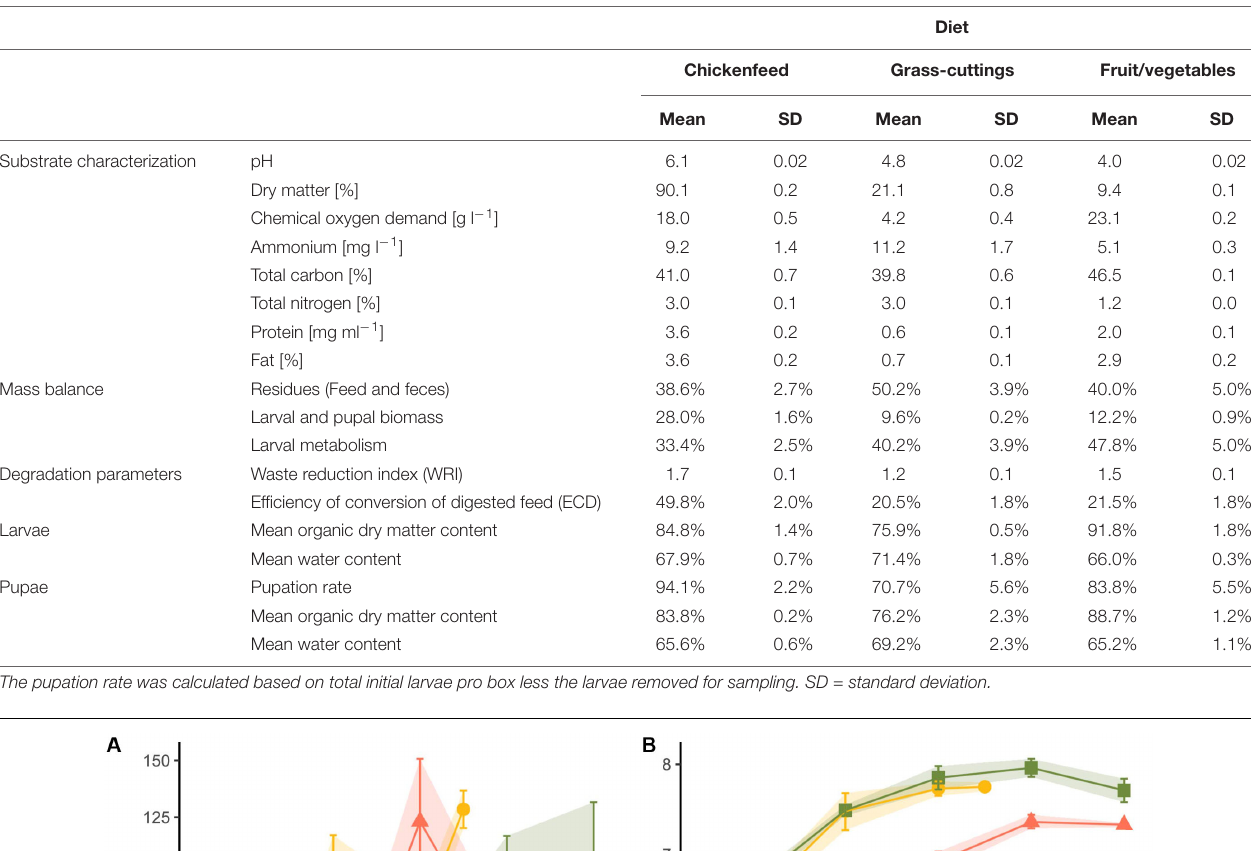
TABLE 1 | Substrate characteristics, mass balance, degradation parameters, and mean compositional indicators of larvae and pupae ( n = 3).